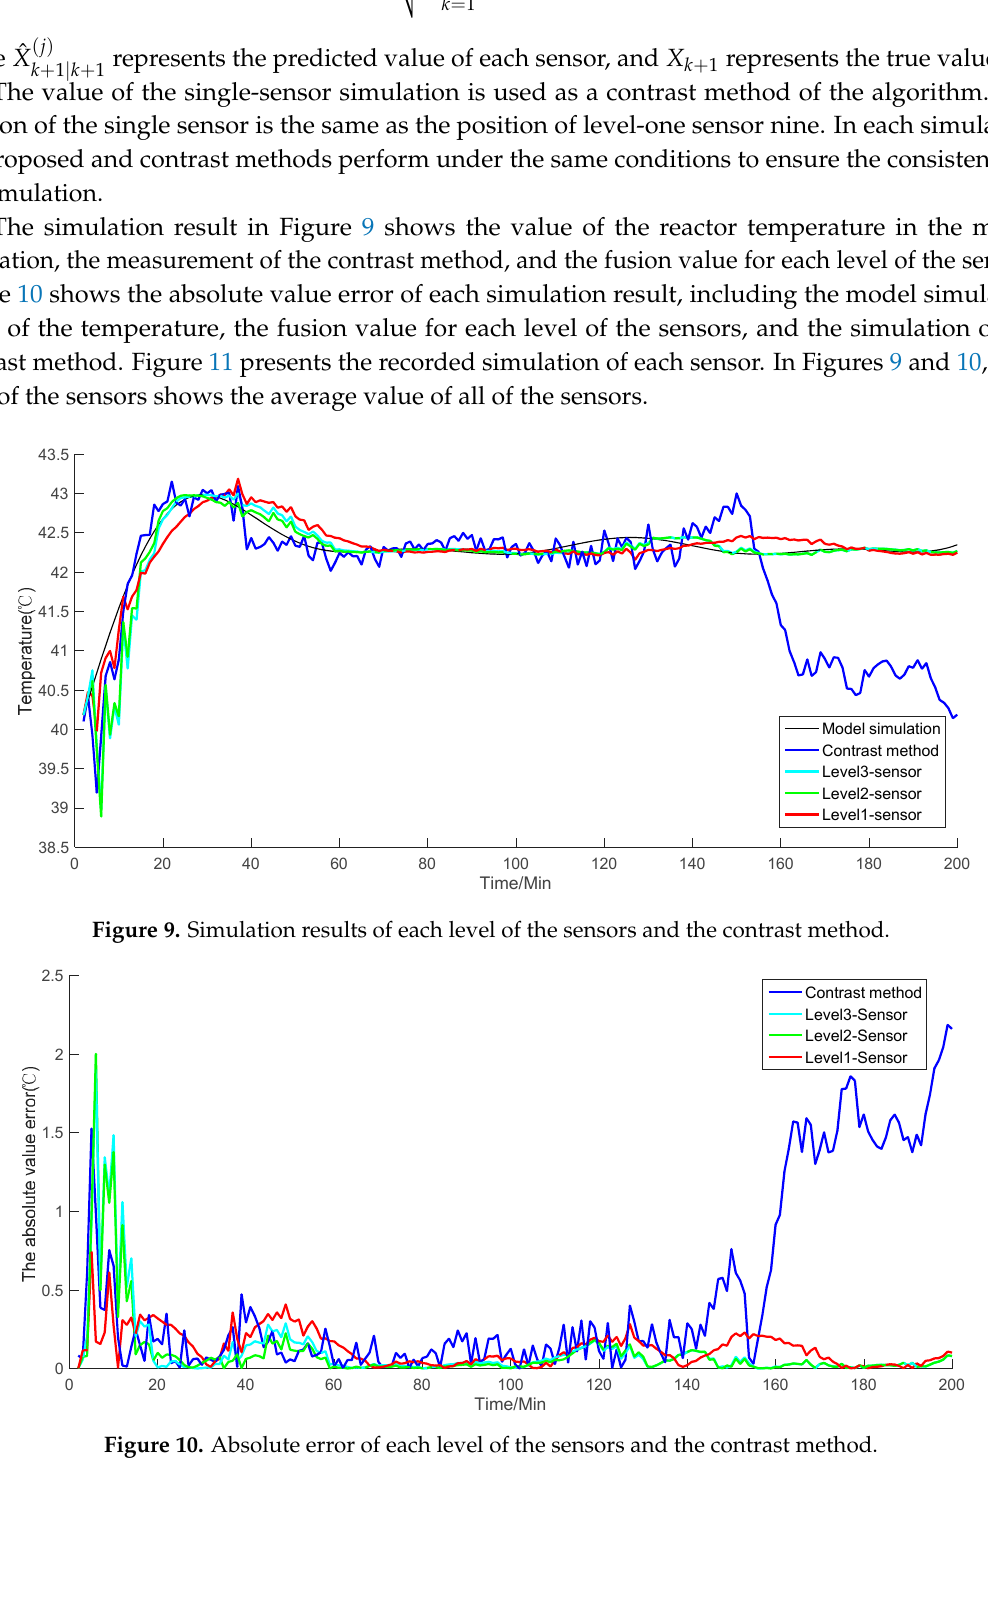
Figure 11. Simulation results of each sensor. The simulation results show that the contrast method has a strong fluctuation (Figures 9 and 10). When the simulation time reaches 140, the contrast method loses accuracy and deviates from the model simulation. Conversely, as the level of the sensor fusion increases, the simulation error becomes increasingly small. On the basis of the given formula, Table 1 shows the average performance index of each level of the sensors. Table1. Mean absolute error (MAE), mean relative error (MRE), and root mean square error (RMSE) of the contrast method and level-three, level-two, and level-one sensor fusion for the simulation case. Type